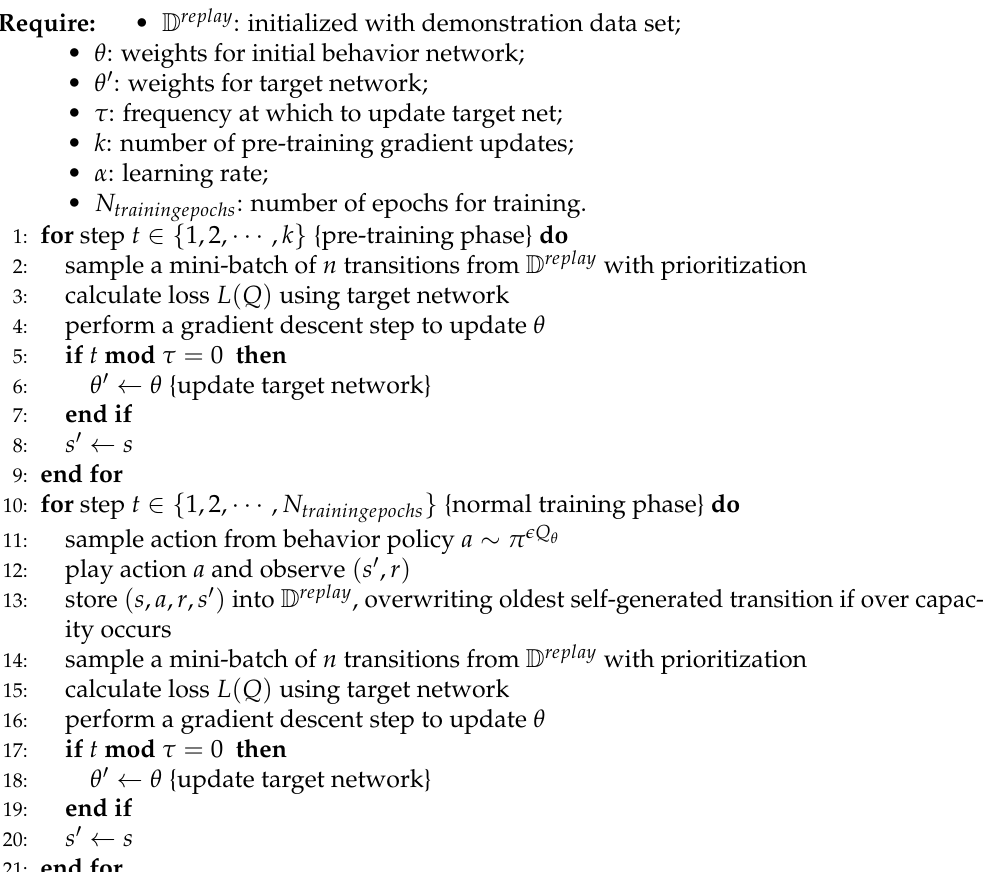
Algorithm 1 Deep Q-Learning from Demonstrations [60] used in [25].